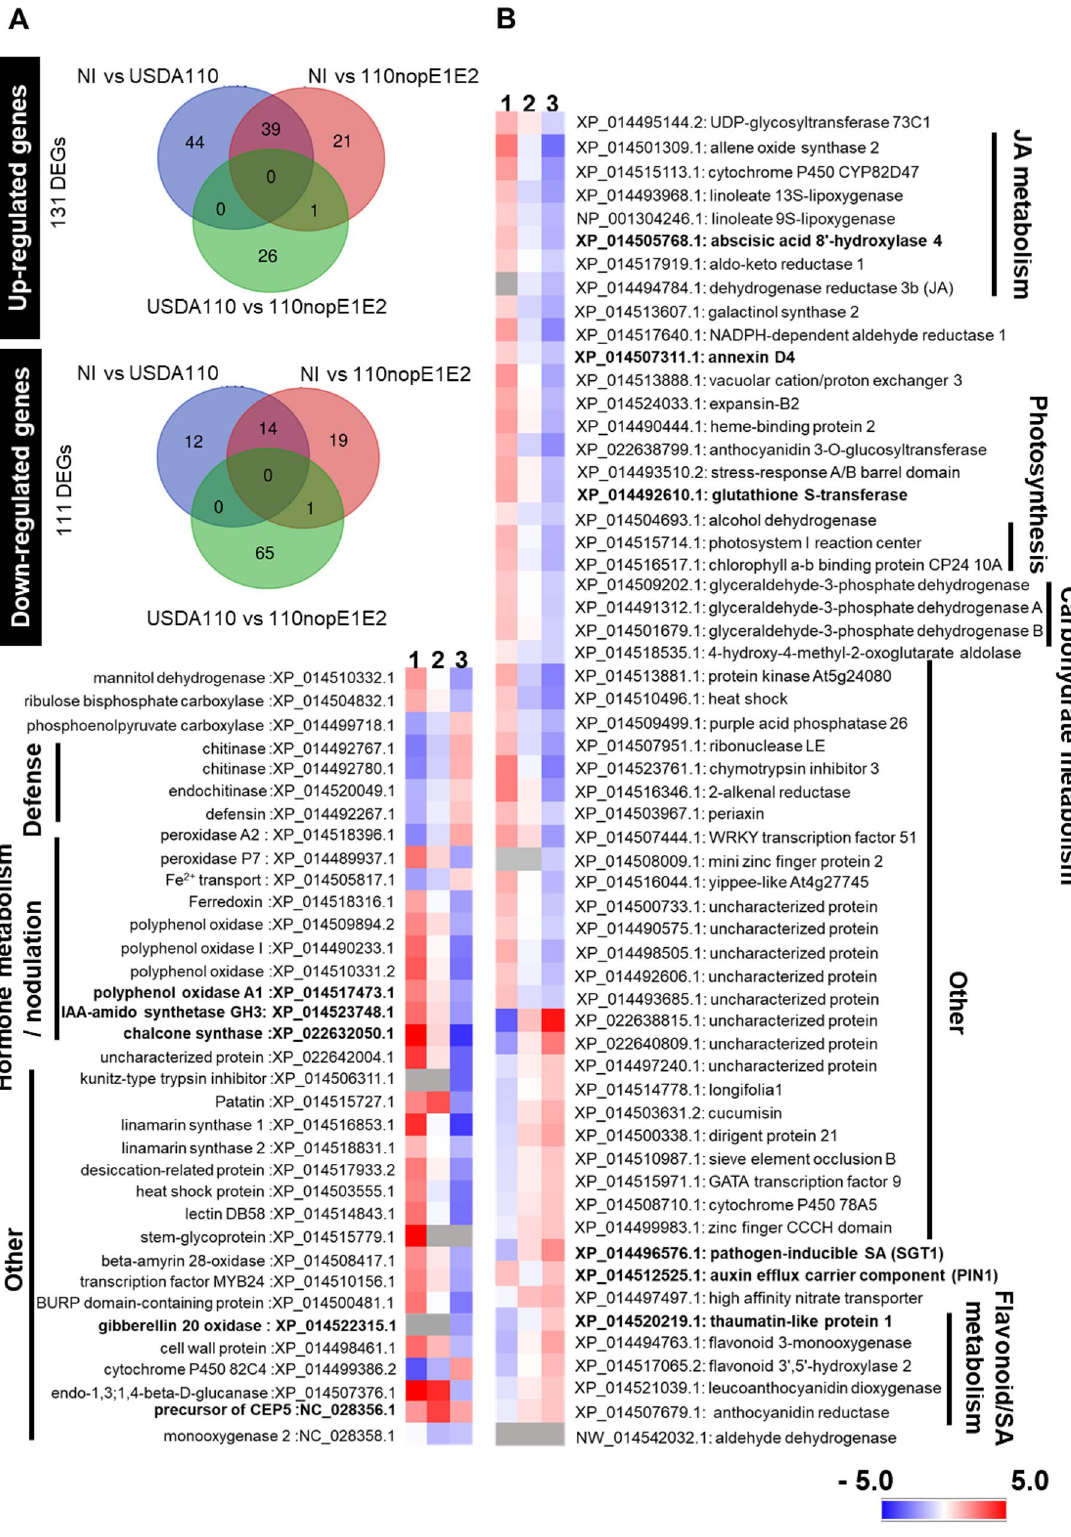
Figure 4. Differentially expressed genes (DEGs) of Vigna radiata KPS1 inoculated with USDA110 versus 110nopE1E2. (A) Venn diagram showing the number of unique differentially expressed genes in each treatment group or in multiple treatment groups: the noninoculation (NI), wild-type USDA110 inoculation (USDA110), and nopE mutant strain inoculation (110nopE1E2) treatment groups. (B) The expression patterns of DEGs of USDA110 vs 110nopE1E2 are focused and displayed as the log 2 fold change ( P adj < 0.05) of the DEGs. The colour scale bars indicate normalized expression levels of DEGs from NI (1), USDA110 (2), and 110nopE1E2 (3). The heat map was constructed by Microsoft Excel